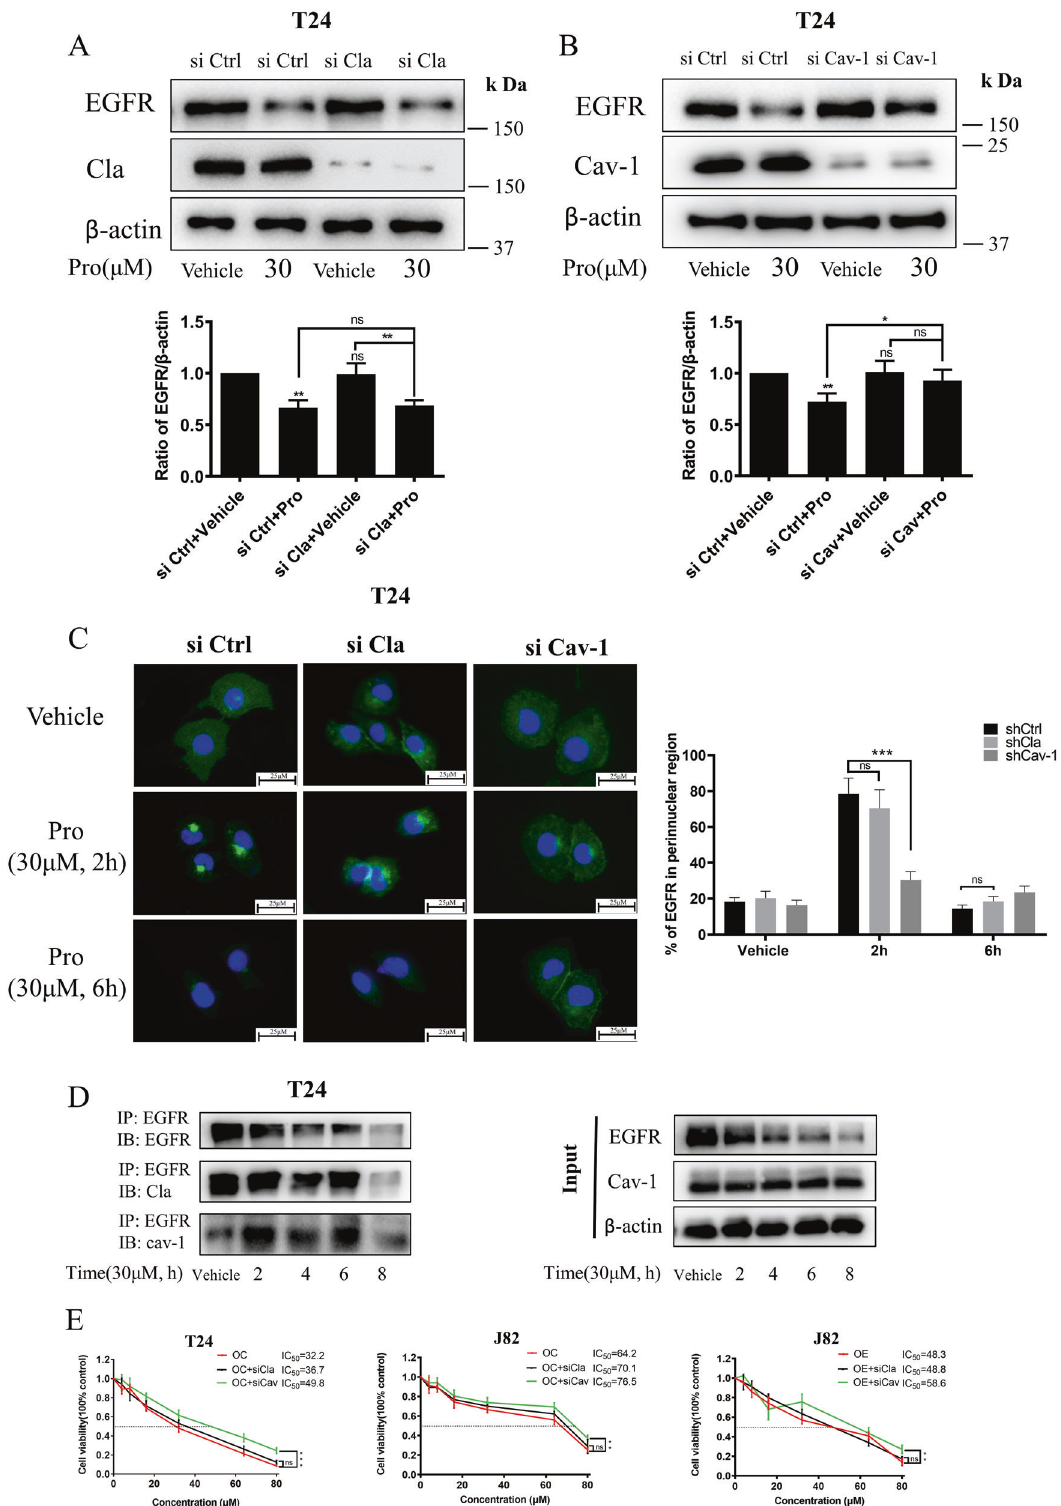
c-Cbl is an E3 ubiquitin ligase that promotes substrate to be labeled by ubiquitin to promote the protein degradation [25]. Importantly, the ability of proguanil to promote EGFR decay was signi fi cantly reduced by silencing c-Cbl while silencing c-Cbl itself has no effect on the expression of EGFR (Fig. 5C).